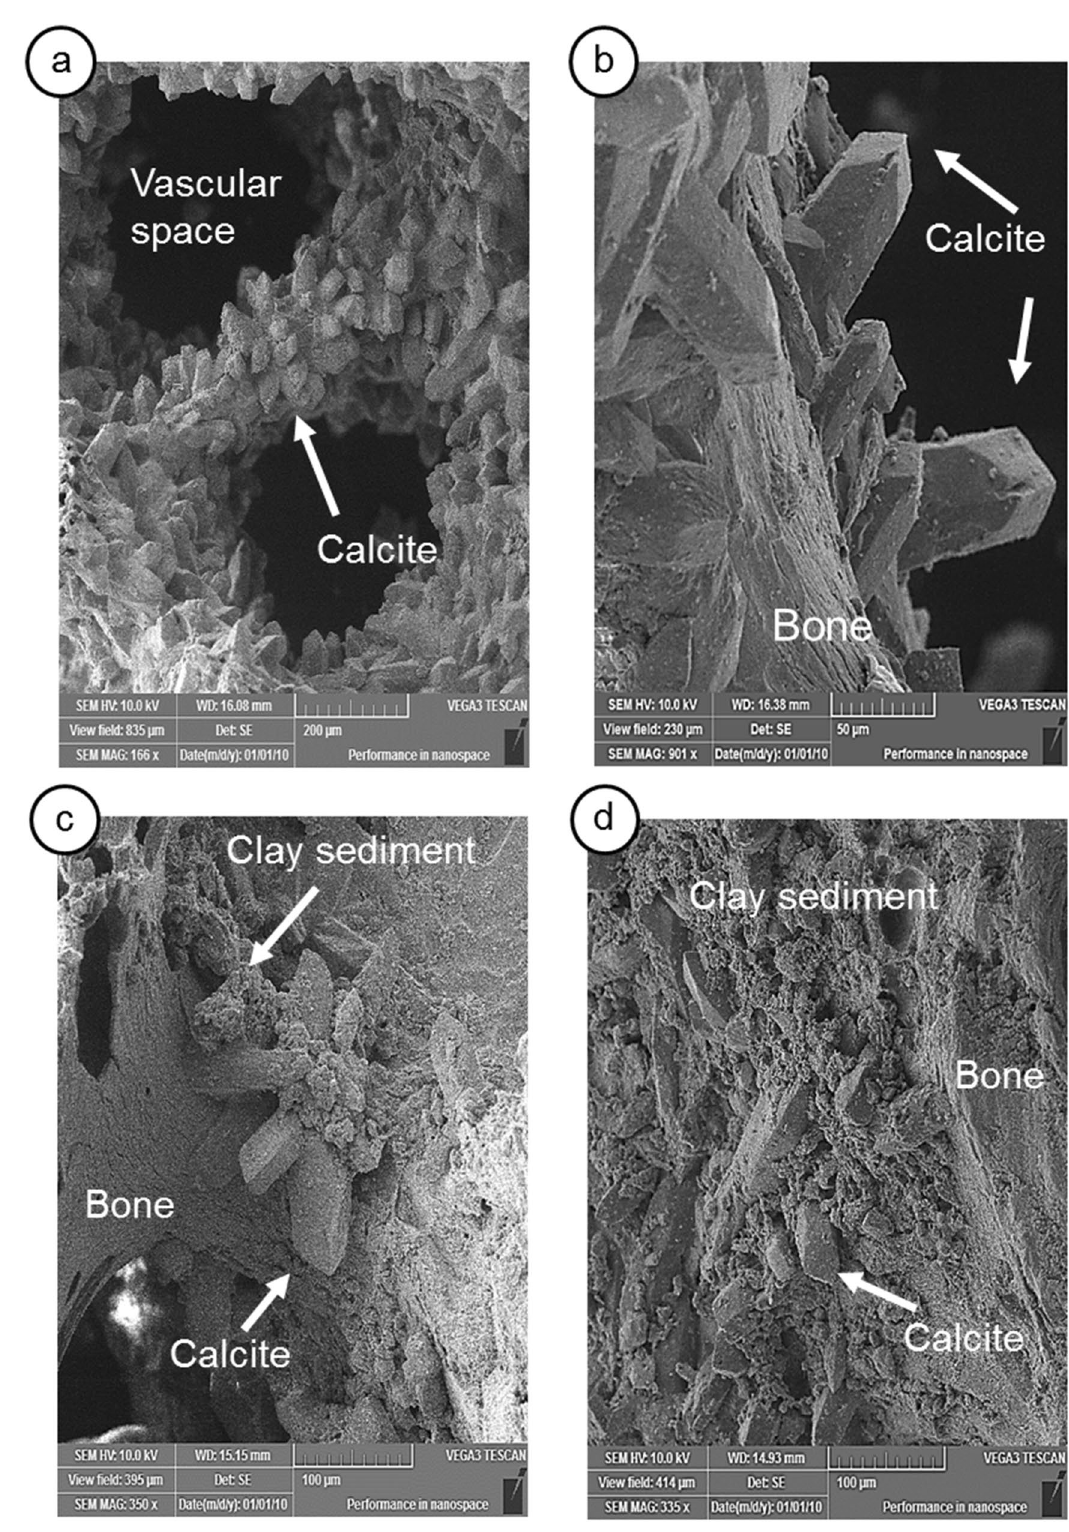
Figure 8. Scanning electron microscopy images of the LAPA/SBF-3-0017 sample. ( a )—Vascular structure, in which it is possible to observe the intense precipitation of calcite crystals. ( b )—Well-developed calcite crystals on the surface of the bone structure. ( c , d )—Bone surface with precipitated calcite crystals that are partially covered by terrigenous